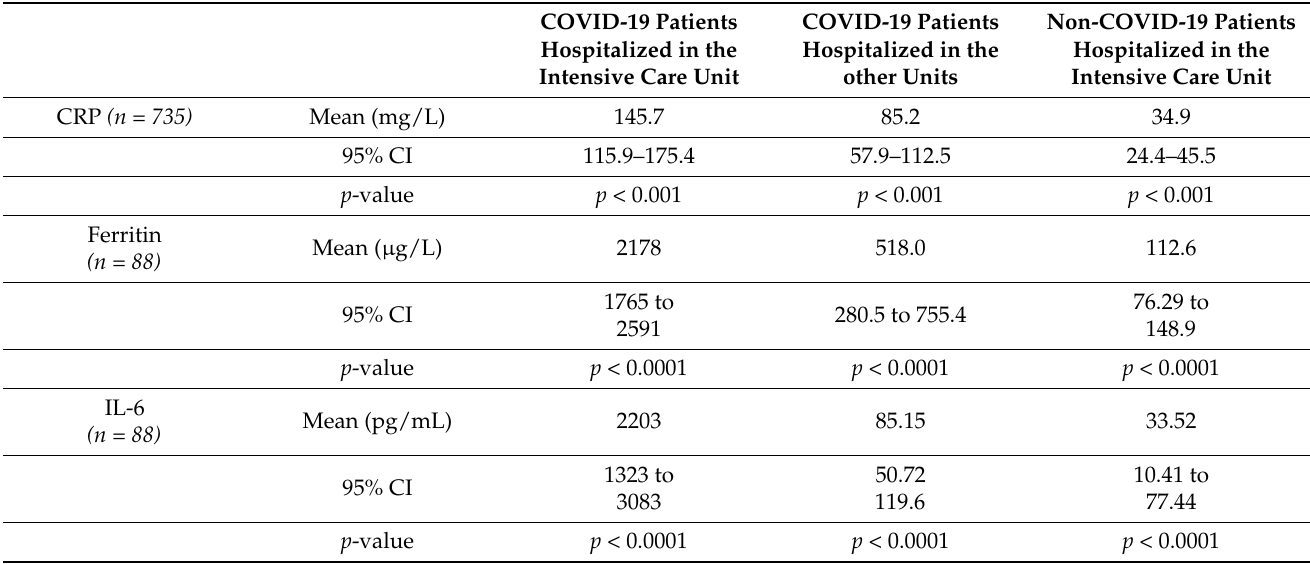
COVID-19 Patients Non-COVID-19 Patients COVID-19 Patients Hospitalized in the